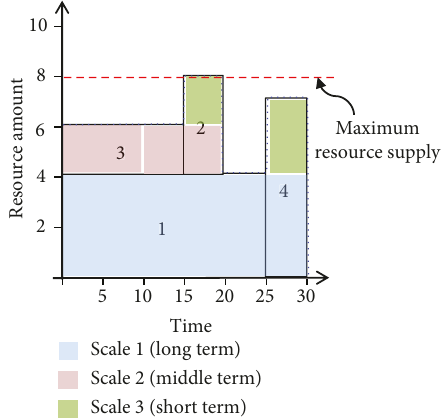
Figure 5: Feasible solution of Figure 4. In Stage 1, the SSS translate the A-list into a sched-